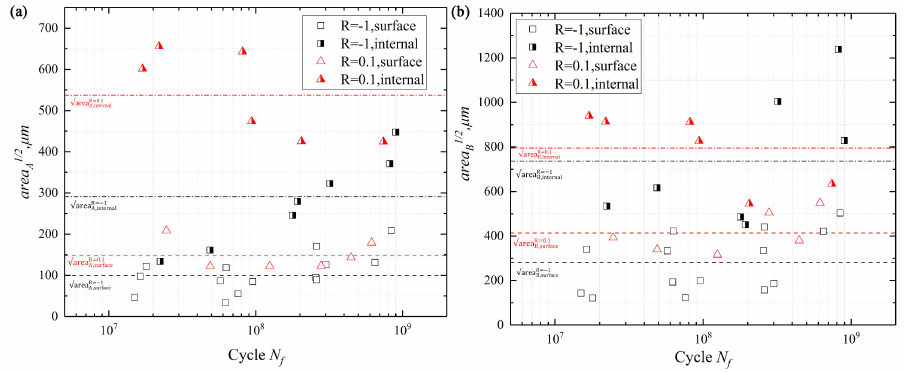
Figure 11. The area of the region ( A ) and ( B ) vs. fatigue life at di ff erent stress